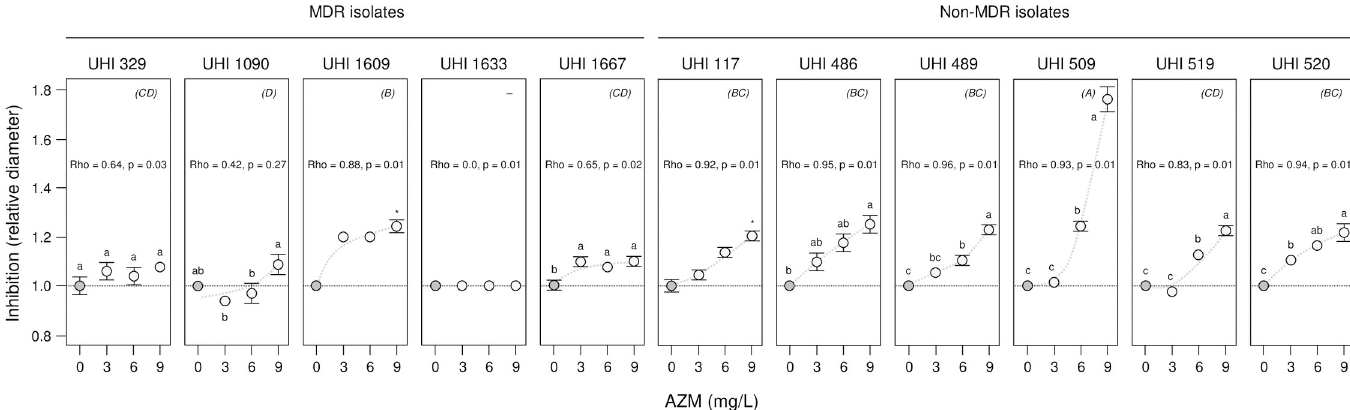
Fig 6. Synergistic inhibition of colony growth of K . pneumonia hospital strains by AZM and polymyxin B. The inhibition of colony growth of multiple-drug resistant (MDR) and non-MDR K . pneumonia Ukrainian Hospital Isolate (UHI) strains was investigated using polymyxin B disks on azithromycin (AZM) plates with colony inhibition zone measurements after 48 h incubation. Mean relative inhibition (mm) ± SE ( n = 3) is shown, with no-AZM (control) treatments indicated by dark circles and 3–9 mg/L AZM treatments by light circles (trends are suggested by dashed curves). Means not connected by the same letters within panels are significantly different (LSMeans Differences Tukey HSD, alpha = 0.05 for individual mixed-effects models of relative inhibition for UHI 329, 509, 520, 1090 & 1667; individual general linear models for UHI 486, 489, 509, 519 & 1633; asterisk indicates significant difference between no AZM and 9 mg/L AZM treatments; Wilcoxon, UHI 117, ChiSquare, DF 1 = 4.1, p = 0.04; UHI 1609, ChiSquare DF 1 = 4.5, p = 0.03). Spearman’s correlation (Rho) between relative inhibition and AZM concentration is provided for each strain. Strains not connected by the same letters indicated in parentheses in the top-right of each panel are significantly different (LSMeans Differences Tukey HSD, alpha = 0.05 for combined UHI strain mixed-effects model of relative inhibition; UHI 1633 was omitted from this analysis as there was no variation in relative inhibition across AZM concentrations and was resistant to polymyxin B).